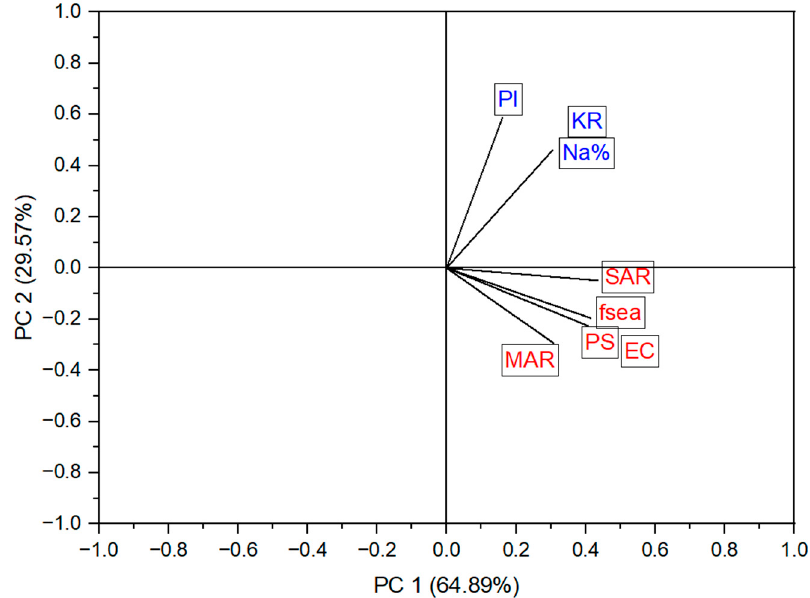
Figure 12. Two-dimensional plot of the principal component factors (PC1 and